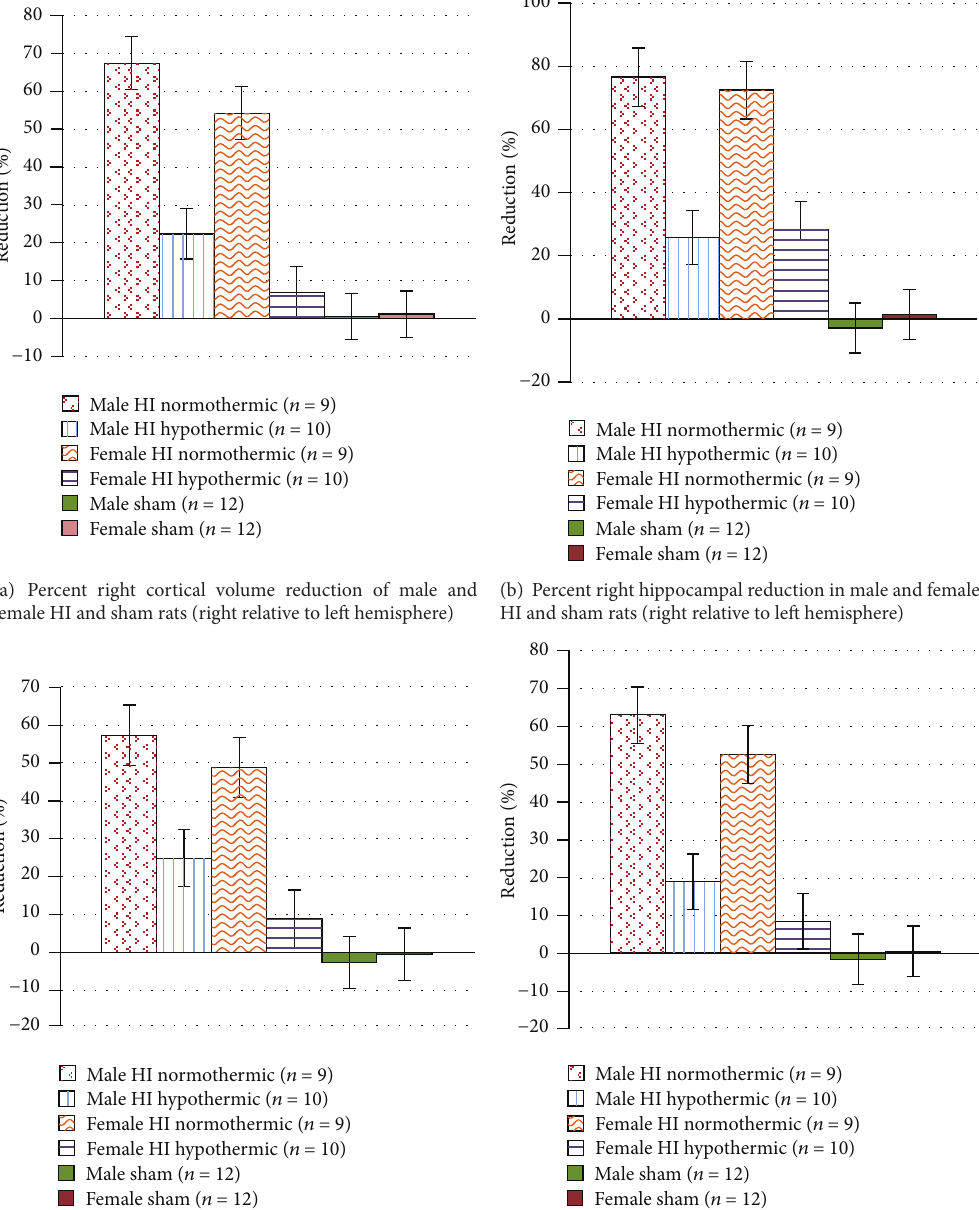
Figure 1: (a) A 2 (Sex) × 2 (Injury) × 2 (Temperature) ANOVA revealed a significant Injury ( 𝑝 < 0.05 ) and Temperature ( 𝑝 < 0.05 ) effect, as well as an Injury × Temperature interaction ( 𝑝 < 0.05 ) and a trend for a Sex × Injury interaction ( 𝑝 = 0.19 ). An independent samples 𝑡 -test between HI normothermic and HI hypothermic animals revealed a significant effect ( 𝑝 < 0.05 ) and a similar effect was seen when 𝑡 -tests were performed for males ( 𝑝 < 0.05 ) and females ( 𝑝 < 0.05 ) separately. (b) A 2 (Sex) × 2 (Injury) × 2 (Temperature) ANOVA revealed a significant Injury ( 𝑝 < 0.05 ) and Temperature ( 𝑝 < 0.05 ) effect, as well as an Injury × Temperature interaction ( 𝑝 < 0.05 ). An independent samples 𝑡 -test between HI normothermic and HI hypothermic animals revealed a significant effect ( 𝑝 < 0.05 ) and a similar effect was seen when 𝑡 -tests were performed for males ( 𝑝 < 0.05 ) and females ( 𝑝 < 0.05 ) separately. (c) A 2 (Sex) × 2 (Injury) × 2 (Temperature) ANOVA revealed a significant Injury ( 𝑝 < 0.05 ) and Temperature ( 𝑝 < 0.05 ) effect, as well as an Injury × Temperature interaction ( 𝑝 < 0.05 ). An independent samples 𝑡 -test between HI normothermic and HI hypothermic animals revealed a significant effect ( 𝑝 < 0.05 ) and this pattern was also seen in females ( 𝑝 < 0.05 ) but not in males ( 𝑝 > 0.05 ). (d) A 2 (Sex) × 2 (Injury) × 2 (Temperature) ANOVA revealed a significant Injury ( 𝑝 < 0.05 ) and Temperature ( 𝑝 < 0.05 ) effect, as well as an Injury × Temperature interaction ( 𝑝 < 0.05 ). An independent samples 𝑡 -test between HI normothermic and HI hypothermic animals revealed a significant effect ( 𝑝 < 0.05 ) and this pattern was also seen in females ( 𝑝 < 0.05 ) but not in males ( 𝑝 > 0.05